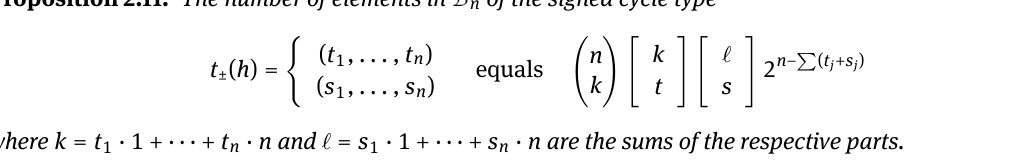
Algorithm 1 : Counting and tabulating the induced permutations of B n . Let n ∈ N be